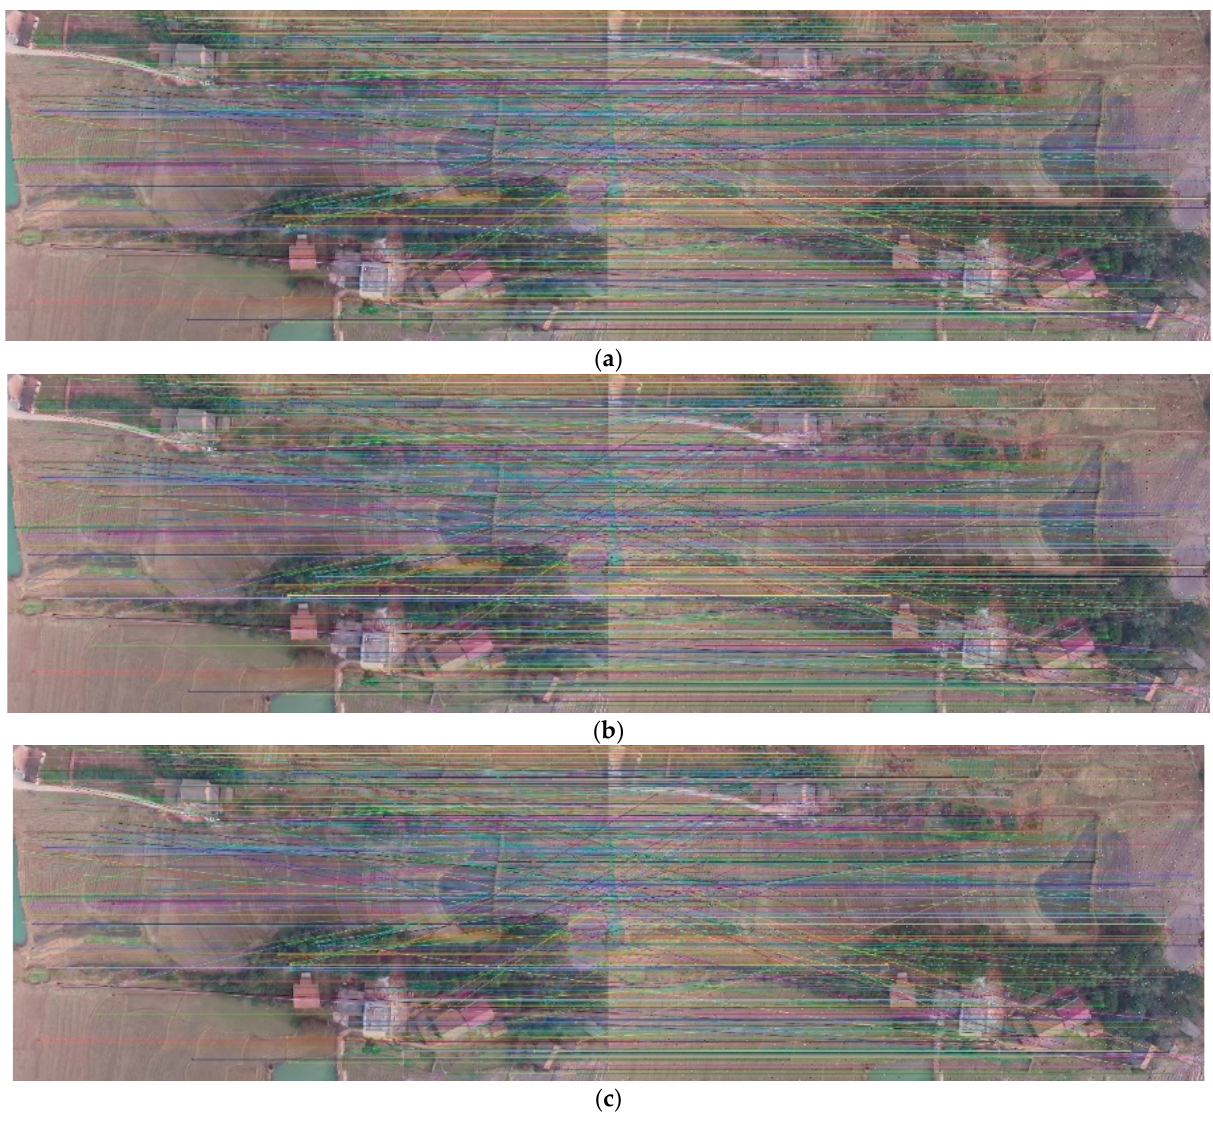
Figure 8. The matching of the original image with the image added with a salt and pepper noise using ( a ) SIFT feature algorithm ( b ) SURF feature algorithm ( c ) ORB feature algorithm.